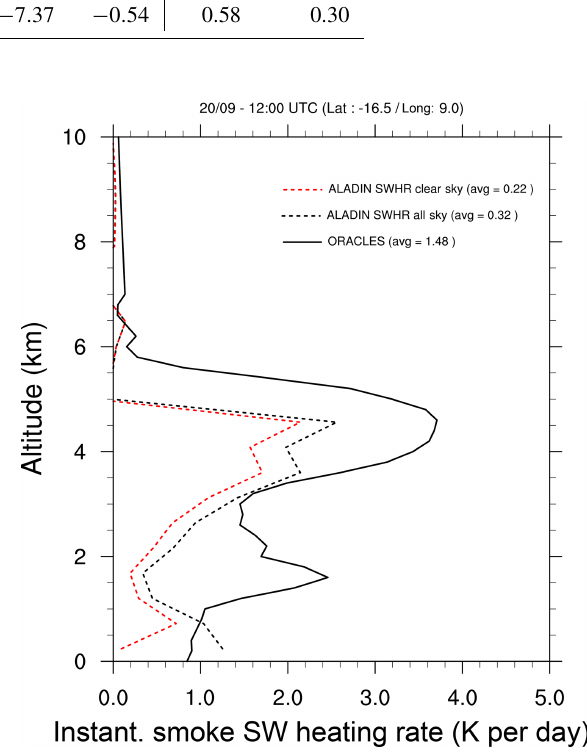
Figure 11. Instantaneous SW heating rate (12:00UTC) only due to smoke aerosols, obtained from ORACLES aircraft data and simu- lated by the ALADIN-Climate model in clear-sky (dashed red lines) and all-sky (dashed blue lines)